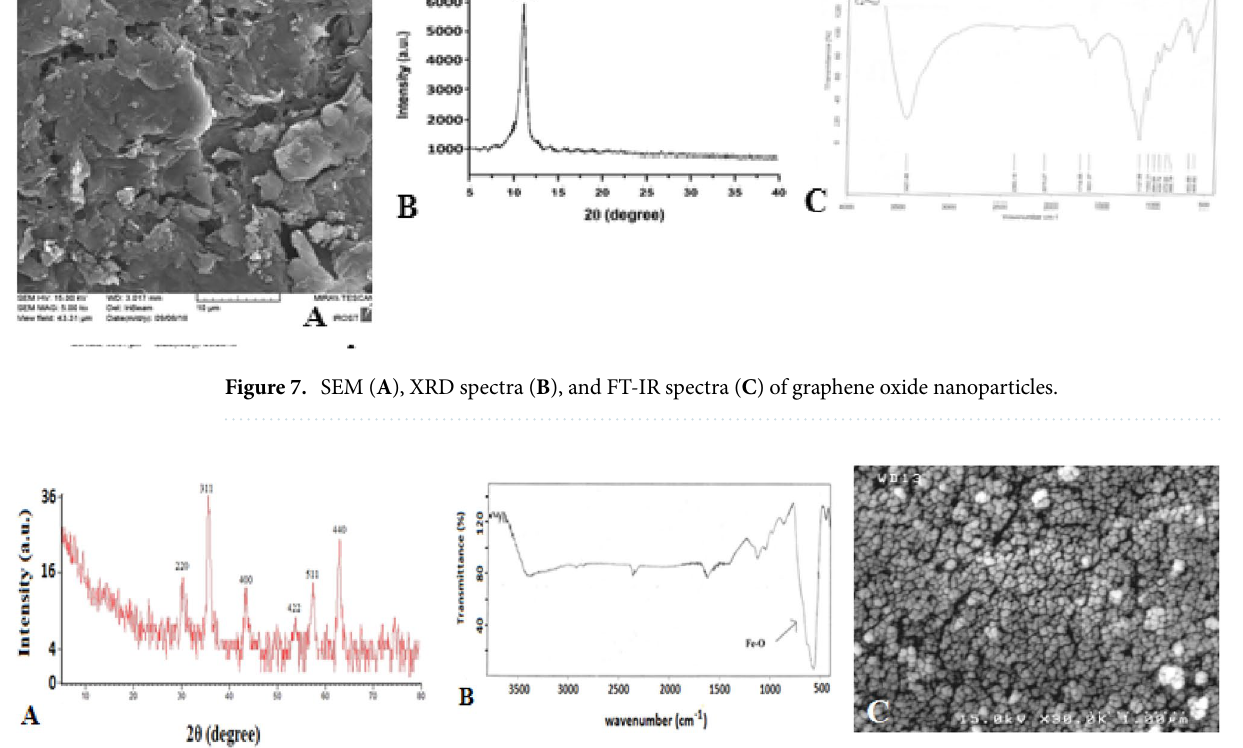
Figure 8. XRD spectrum ( A ), FT-IR spectrum ( B ), and FE-SEM ( C ) of Fe 3 O 4